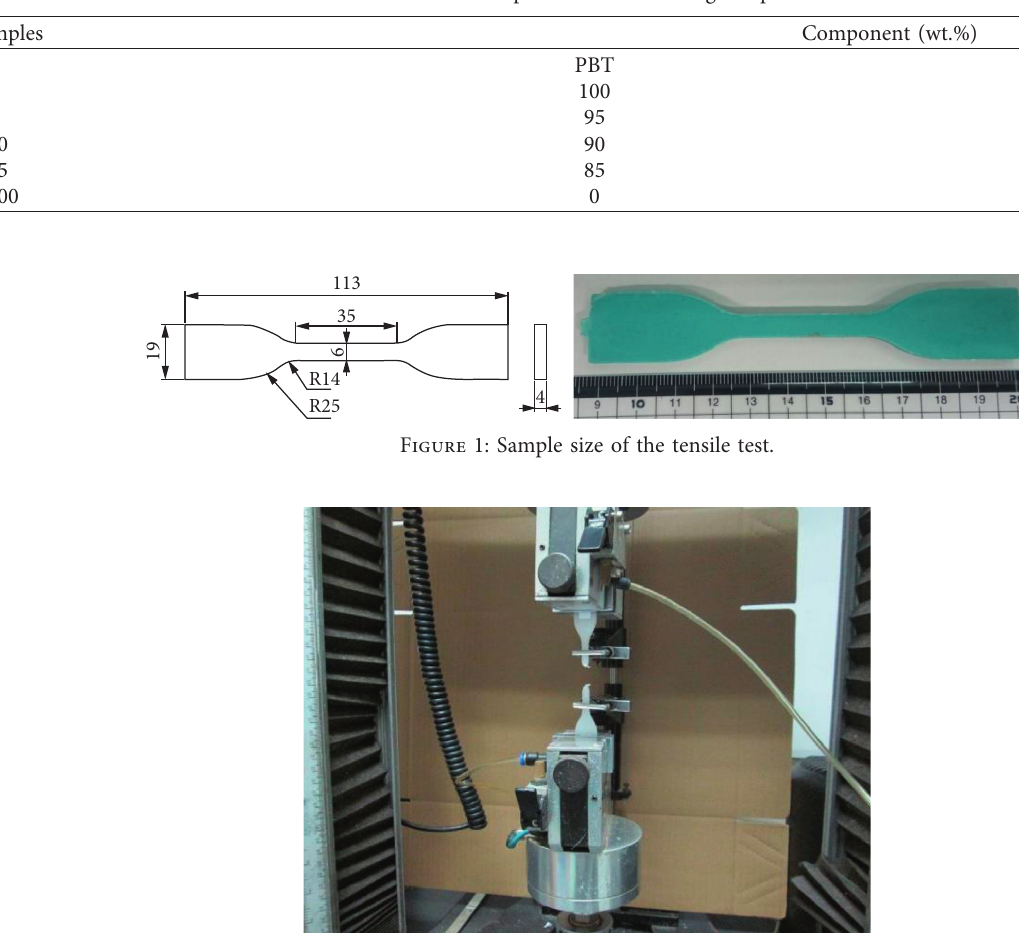
Figure 2: Sample mounted on the universal Shimadzu Autograph AG-X Plus machine.